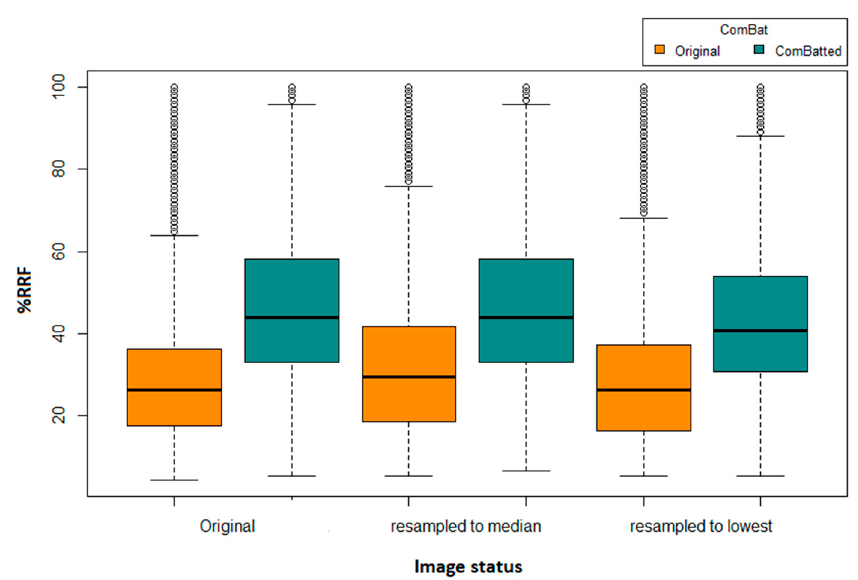
Figure 2. Boxplot of the number of reproducible HRFS (RRFs) across the different scenarios.